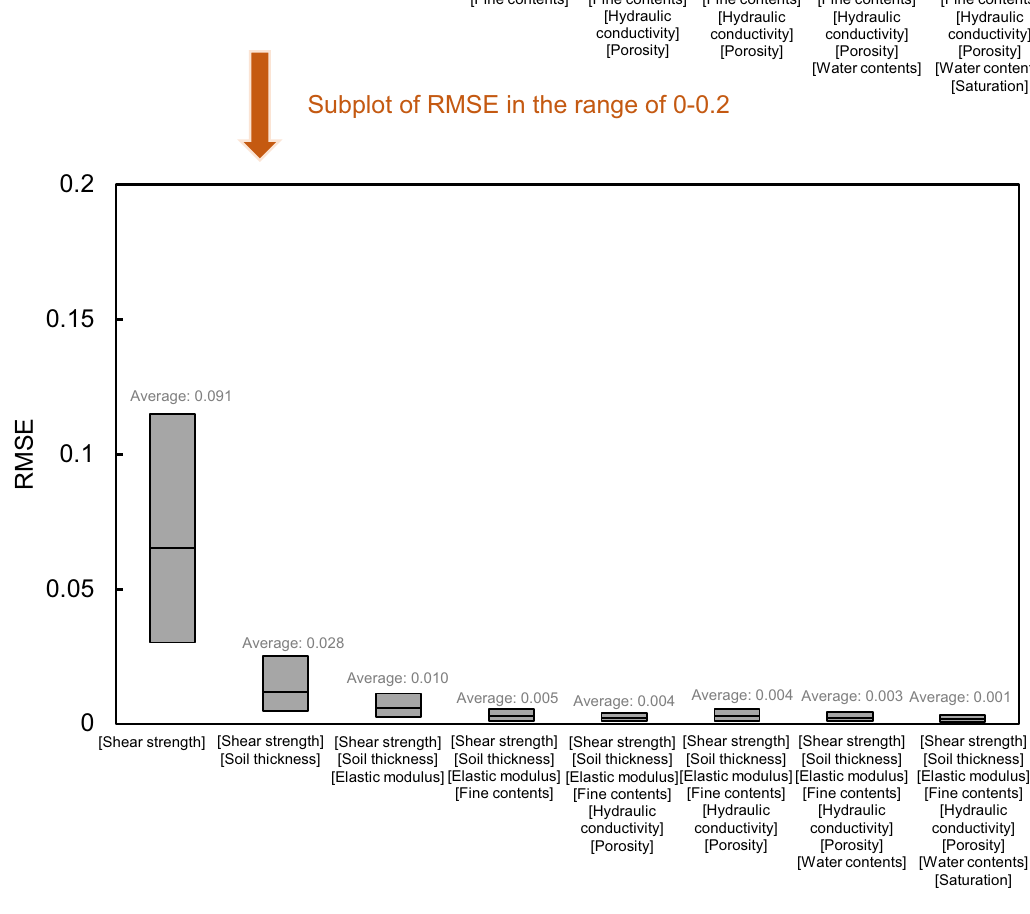
Figure 22. Box plot of RMSE according to the optional input variable in the neural